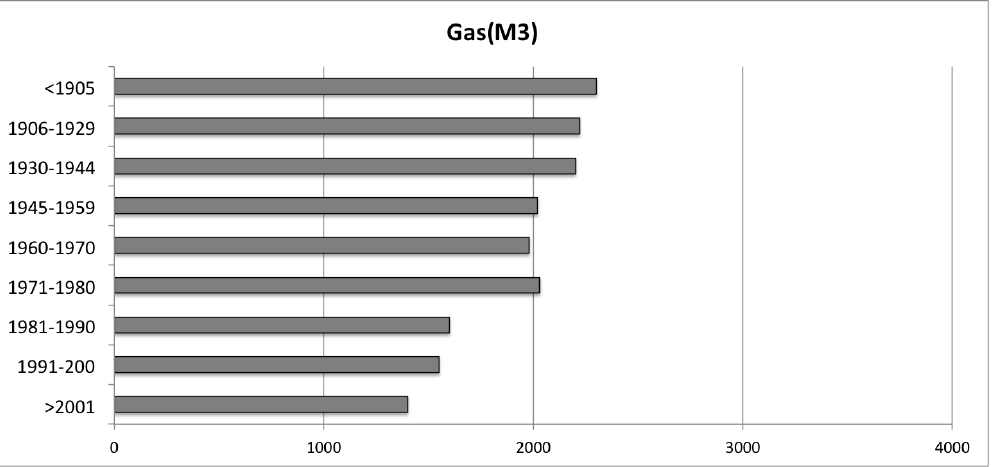
Figure 3. Annual energy consumption and constrution year (redrawn from